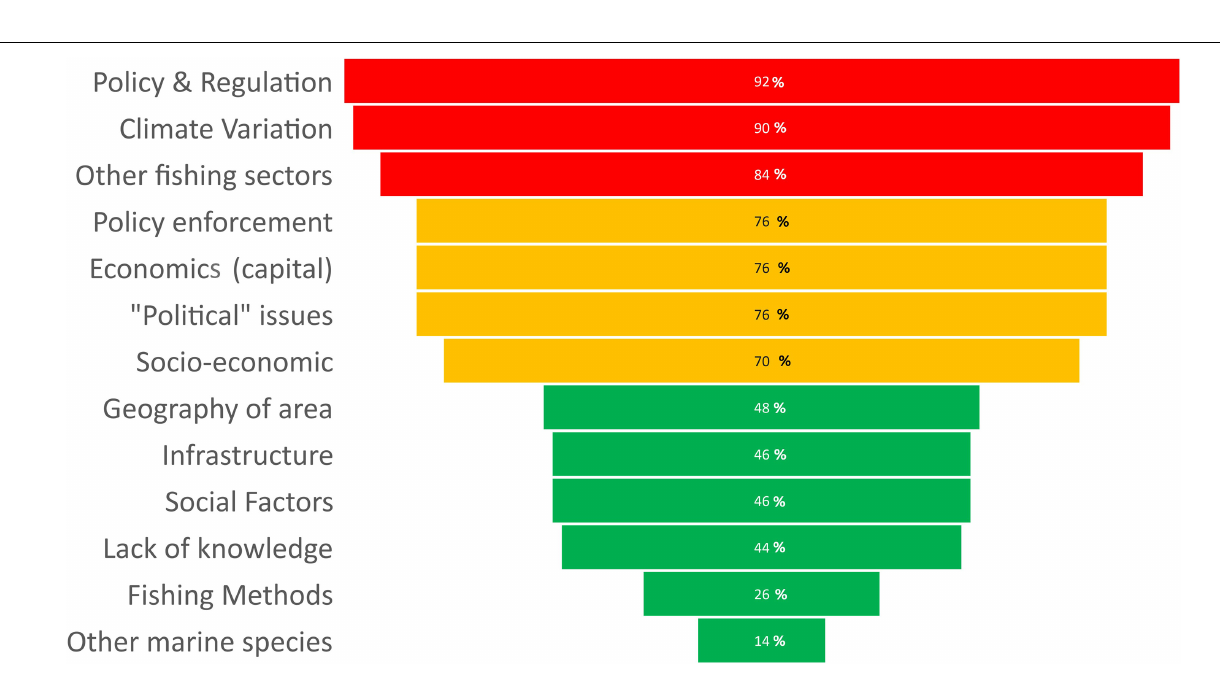
Frontiers in Marine Science |